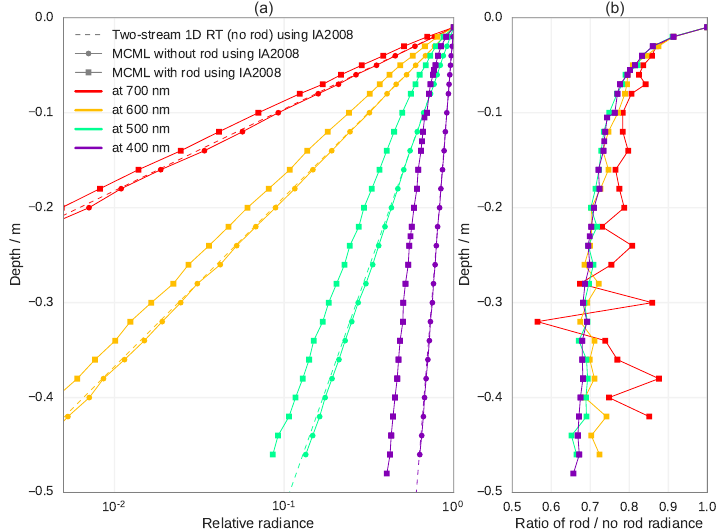
Figure 9. (a) Log-radiance profiles at 400, 500, 600, and 700nm simulated with the 1-D model TARTES (without rod) and the 3-D model MCML (with and without rod) for a homogeneous snowpack with SSA of 30m 2 kg − 1 and density of 350kgm − 3 . (b) Same as (a) but normalized by the ideal case computed with